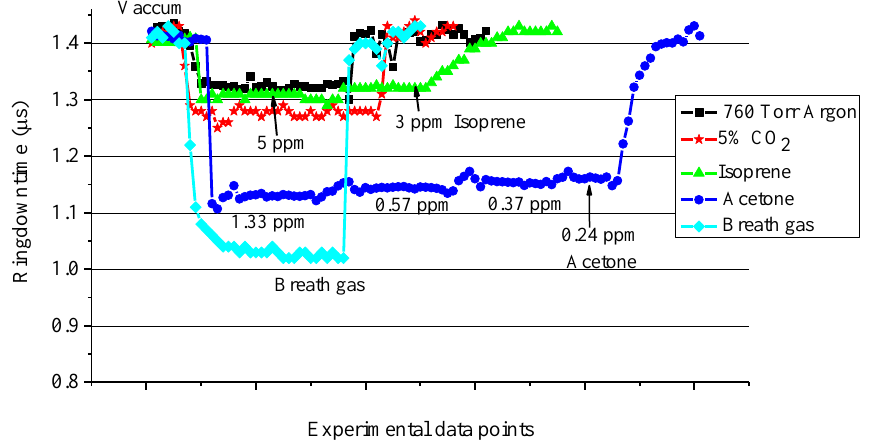
Figure 7. Comparison of ringdown absorption measurements of acetone, CO and actual human exhaled breath